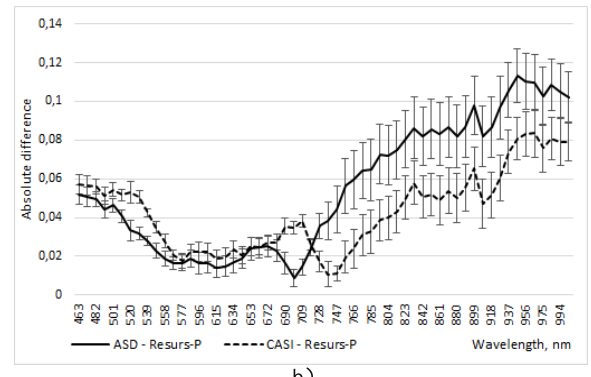
Figure 6. Average reflectance of grassland from Resurs-P, CASI and ASD data for test site 1 (a). Average absolute differences (AbsDif) in reflectance spectra between ASD and Resurs-P, and between CASI and Resurs-P (b). Confidence level of 95%. Figure 4. Radiometric correction coefficients for Resurs-P image